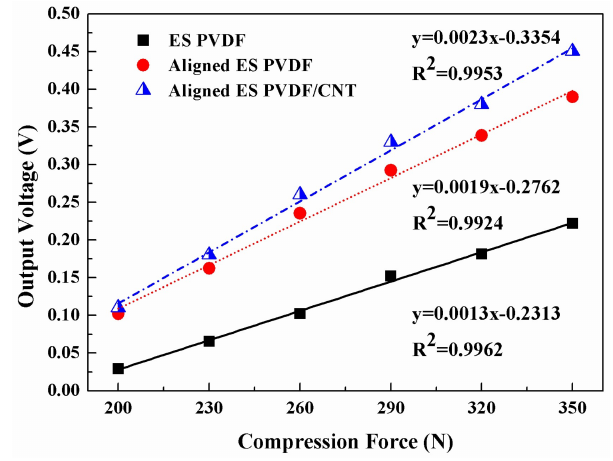
Figure 5. Applied compressive force vs. output voltage of the piezoelectric PVDF